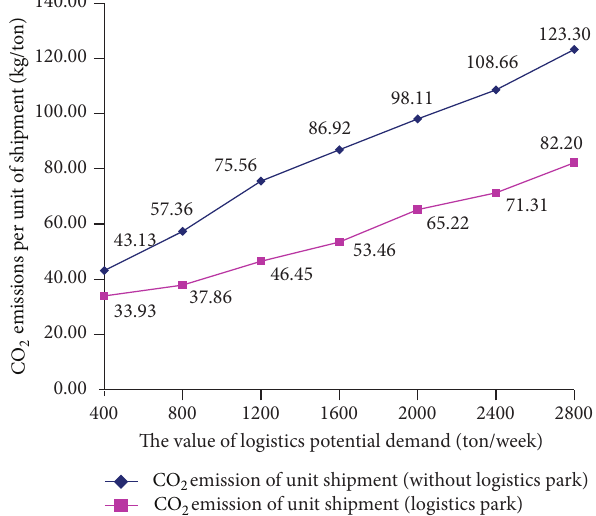
Figure 10: Unit shipment CO 2 emission comparison with con- structing logistics parks and without constructing logistics